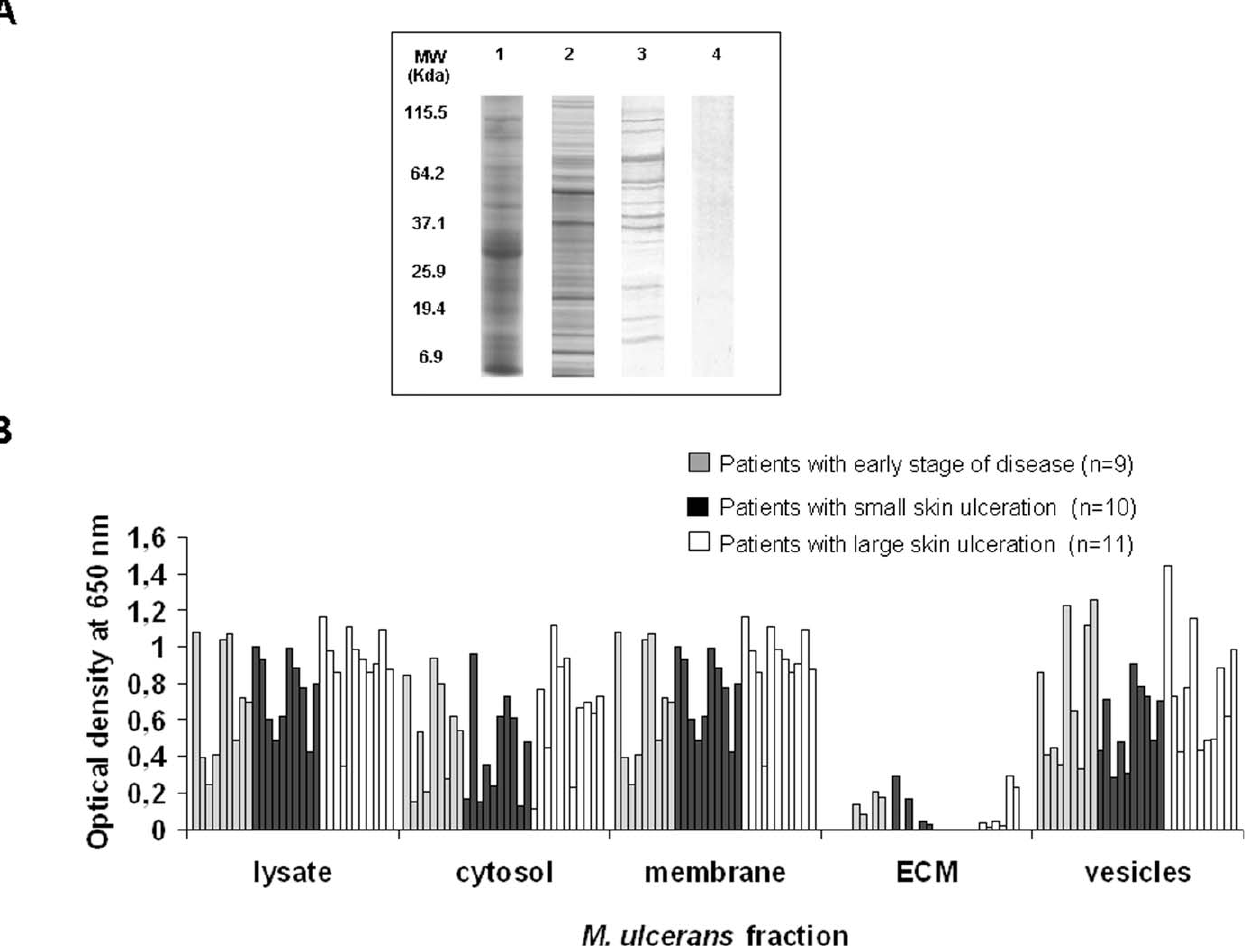
Figure 4. ECM Is a Poor Source of Antigens (A) Western blotting with one representative human serum sample on M. ulcerans lysate or on ECM fraction. Proteins (20 l g) extracted from M. ulcerans lysate (lanes 1 and 3) or from ECM (lanes 2 and 4) were loaded on a 4%–12% SDS-PAGE gel and transferred to nitrocellulose. Lanes 1 and 2: Coomassie staining. Lanes 3 and 4: Detection with serum from a Buruli ulcer patient, and anti-human horse radish peroxidase-conjugated IgG. Many antigens were detected in the M. ulcerans lysate, whereas none were found in ECM. (B) Detection of reactive IgG by ELISA in M. ulcerans lysate, membrane, cytosolic, ECM, and vesicle fractions. Samples were divided into three groups according to the patients’ clinical stage of disease: no ulceration, limited ulceration, and extensive ulceration. Comparison using one way analysis of variance followed by the Newman–Keuls multiple comparison test shows that the relative titre of IgG binding to antigens from ECM was significantly less compared to that of the other